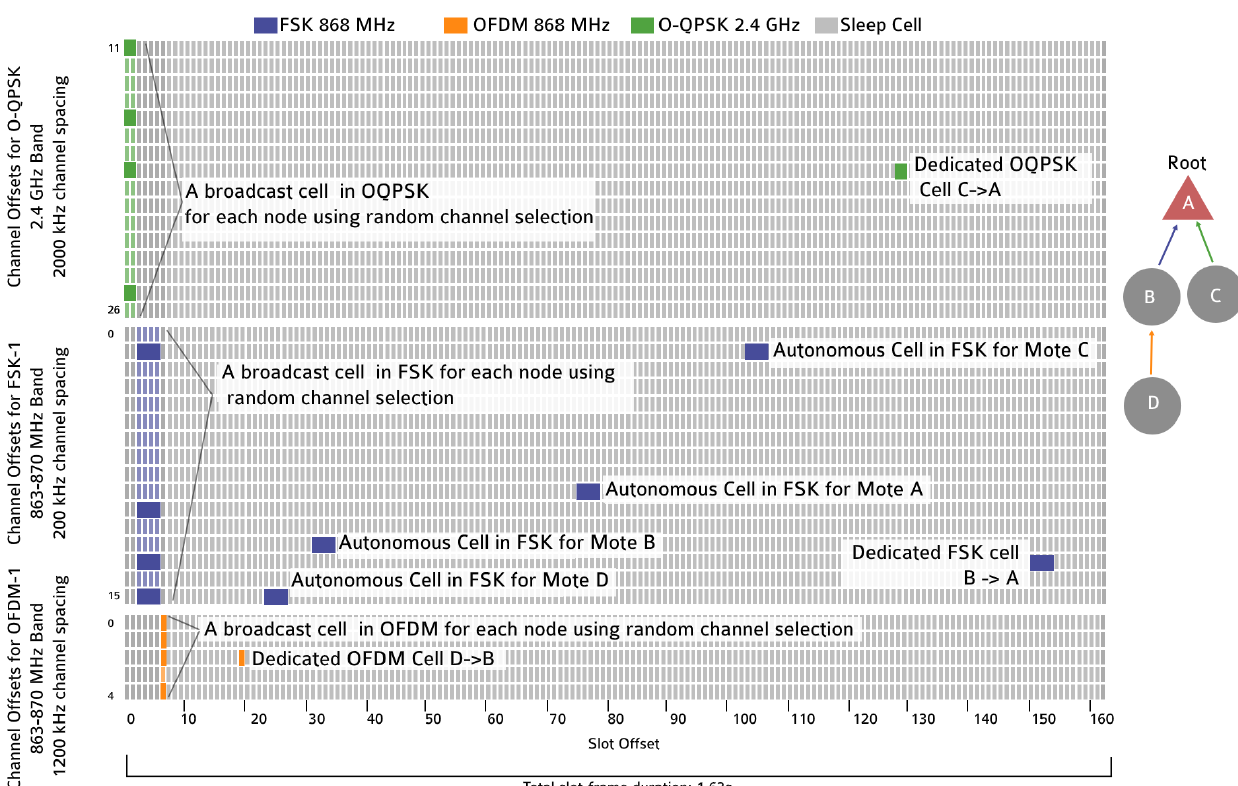
Figure 4. A heterogeneous slotframe for an example multihop topology, including broadcast cells for multi-PHY network